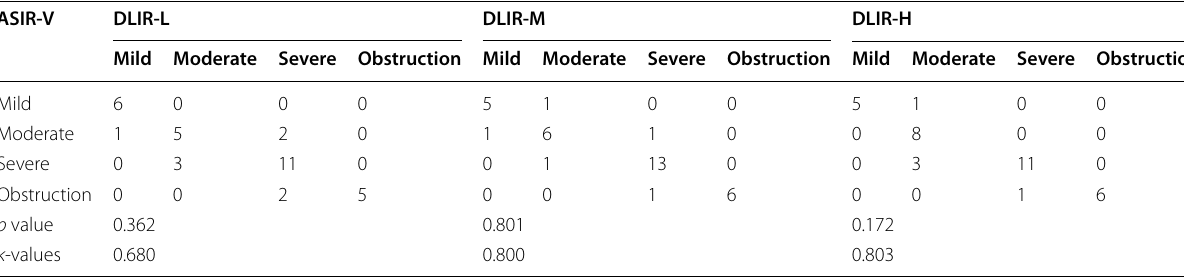
ASIR, adaptive statistical iterative reconstruction-Veo; DLIR, deep learning image reconstruction (low strength, DLIR-L; medium strength, DLIR-M; high strength, DLIR-H)